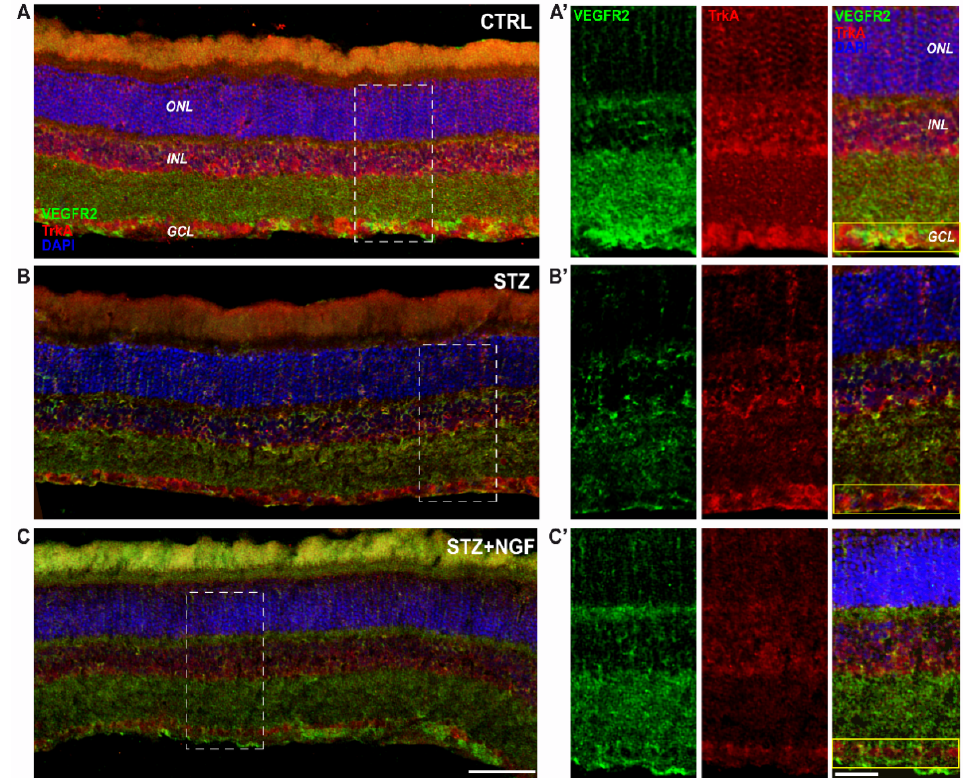
Figure 6. ( A – C ). Distribution of TrkA and VEGFR2 in the retinal layers of healthy and diabetic rat retina, with or without topical NGF administration. ( A – C ) The immunostaining of rat retinal sections showed the different localization of TrkA (red) and VEGFR2 (green), distributed through the retinal layers: ONL, INL, and GCL. Cell nuclei were labeled by DAPI staining (blue). ( A’ – C’ ) The high magnification reported the separated channels of TrkA/VEGFR2 staining in the retinal layers, focusing on the GCL. Islets corresponding to the scale bar: 100 µm, islet: 30 µm. CTRL, healthy rats; STZ, streptozotocin; STZ+NGF, streptozotocin+nerve growth factor eye drops.